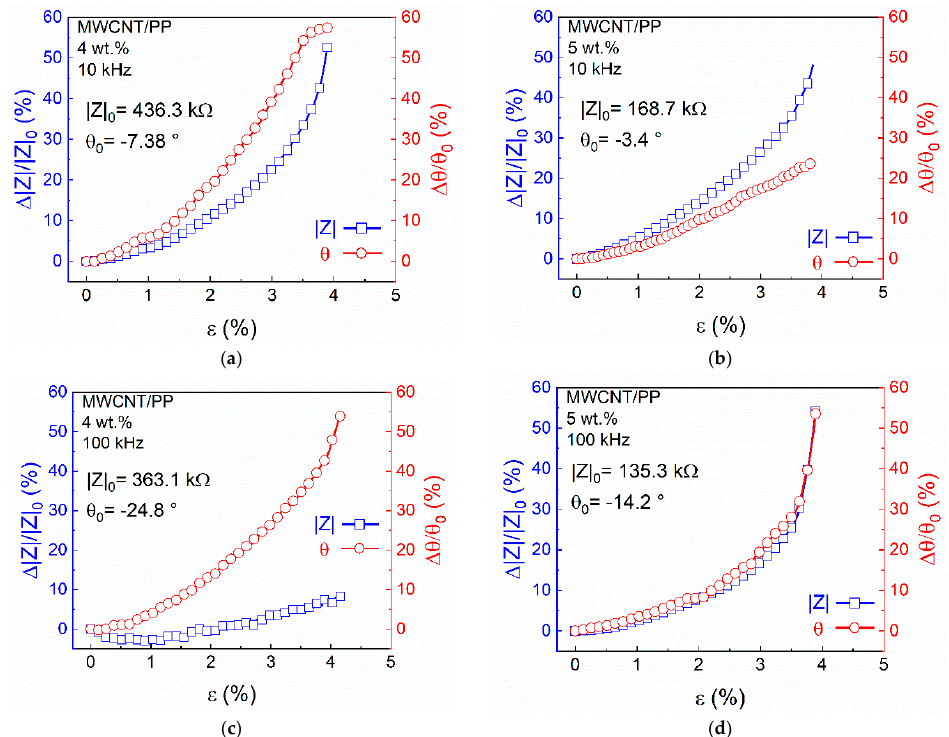
Figure 4. Piezoimpedance response of nanocomposites (resistive configuration) as a function of MWCNT content and frequency. ( a ) 10 kHz (4 wt.%); ( b ) 10 kHz (5 wt.%); ( c ) 100 kHz (4 wt.%); ( d ) 100 kHz (5 wt.%).